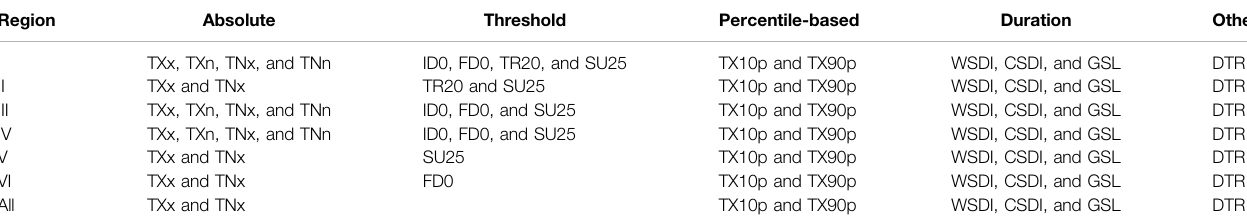
TABLE 3 | Extreme temperature indices for six regions over China.